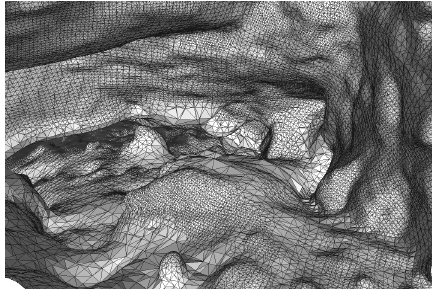
Figure 5. A sample of the mesh obtained from Poisson surface reconstruction using MeshLab .